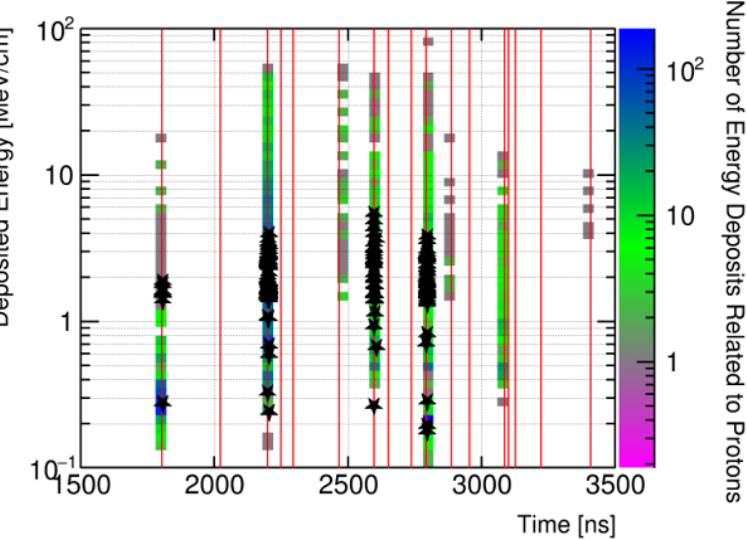
Figure 25. The simulated temporal distribution of neutrino vertices (red lines) within a portion of a beam spill in ND-LAr. The mean separation of neutrino vertices is 279ns. The filled bins show the number of hits due to recoiling protons, stars indicate a hit due to a recoiling 2 H, 3 H, 2 He or 3 He nucleus. All fast-neutron induced energy deposits occur < 10ns after each neutrino